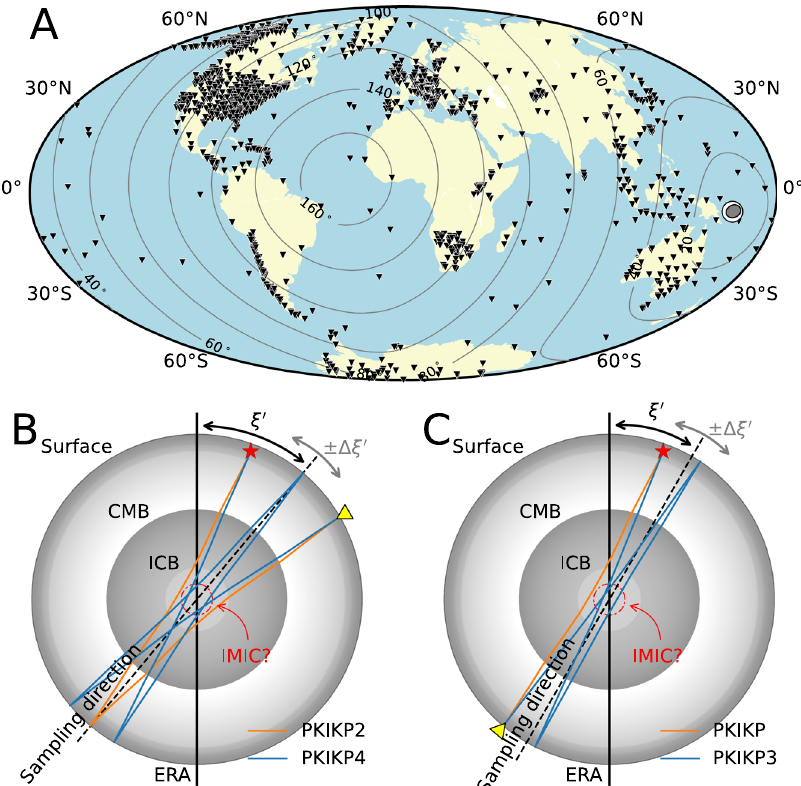
Fig. 1 | Location map and schematic ray paths of PKIKP multiples. A The loca- tion map of the 22 Jan 2017, Mw 7.9 Solomon Islands earthquake and stations that contribute to the global stack (see Fig. 2). Black inverted triangles denote the seismic stations, and beachball marks the location and mechanism of the earth- quake.Thecontoursshowtheepicentraldistancesfromtheevent. B Schematicray paths of the second and fourth PKIKP multiples, i.e., PKIKP2 and PKIKP4,